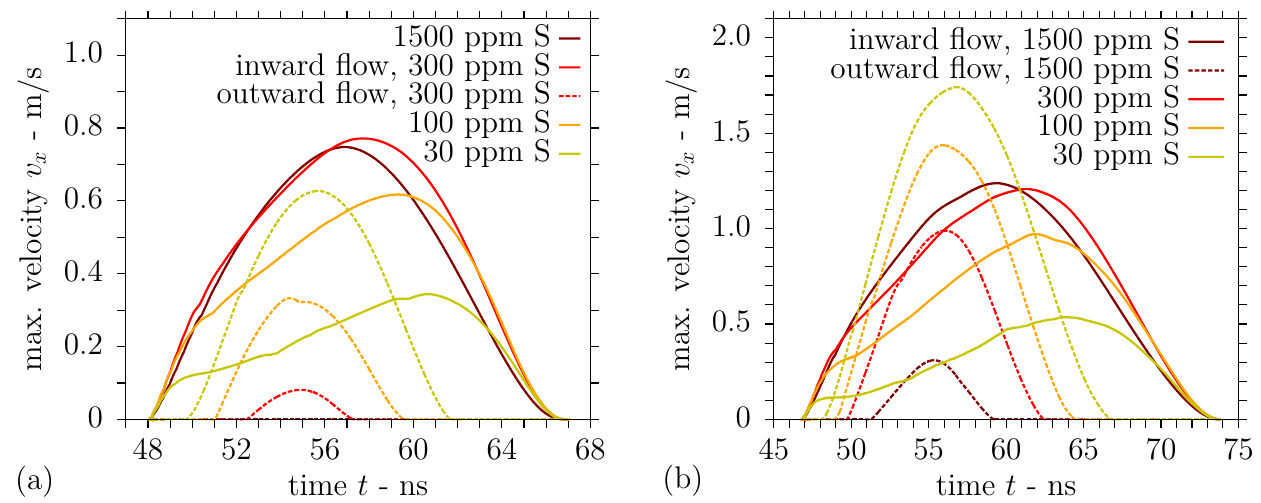
Figure 11. Horizontal velocity magnitudes at melt pool surface during DLIP with λ = 1053 nm, Λ = 7.2 µm, and τ p = 12 ns using a fluence of ( a ) 2 Φ 0 = 0.532 J/cm 2 or ( b ) 2 Φ 0 = 0.665 J/cm 2 on steel with sulphur